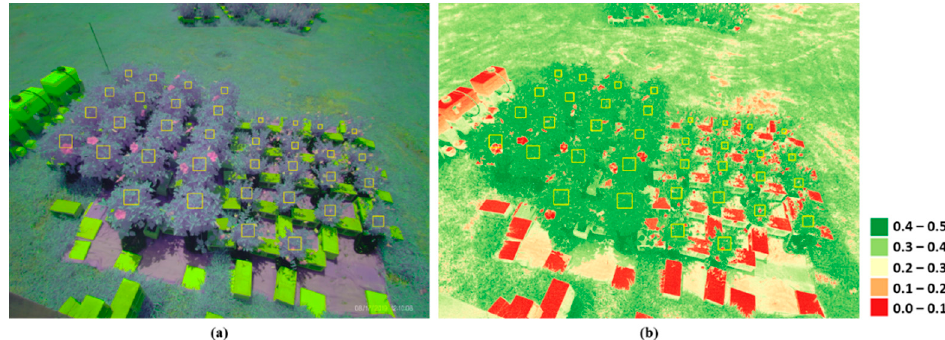
Figure 2. Examples of ( a ) false color and ( b ) NDVI images obtained from an image collected on 17 August 2019. The boxes in yellow indicate AOIs for the individual plants.